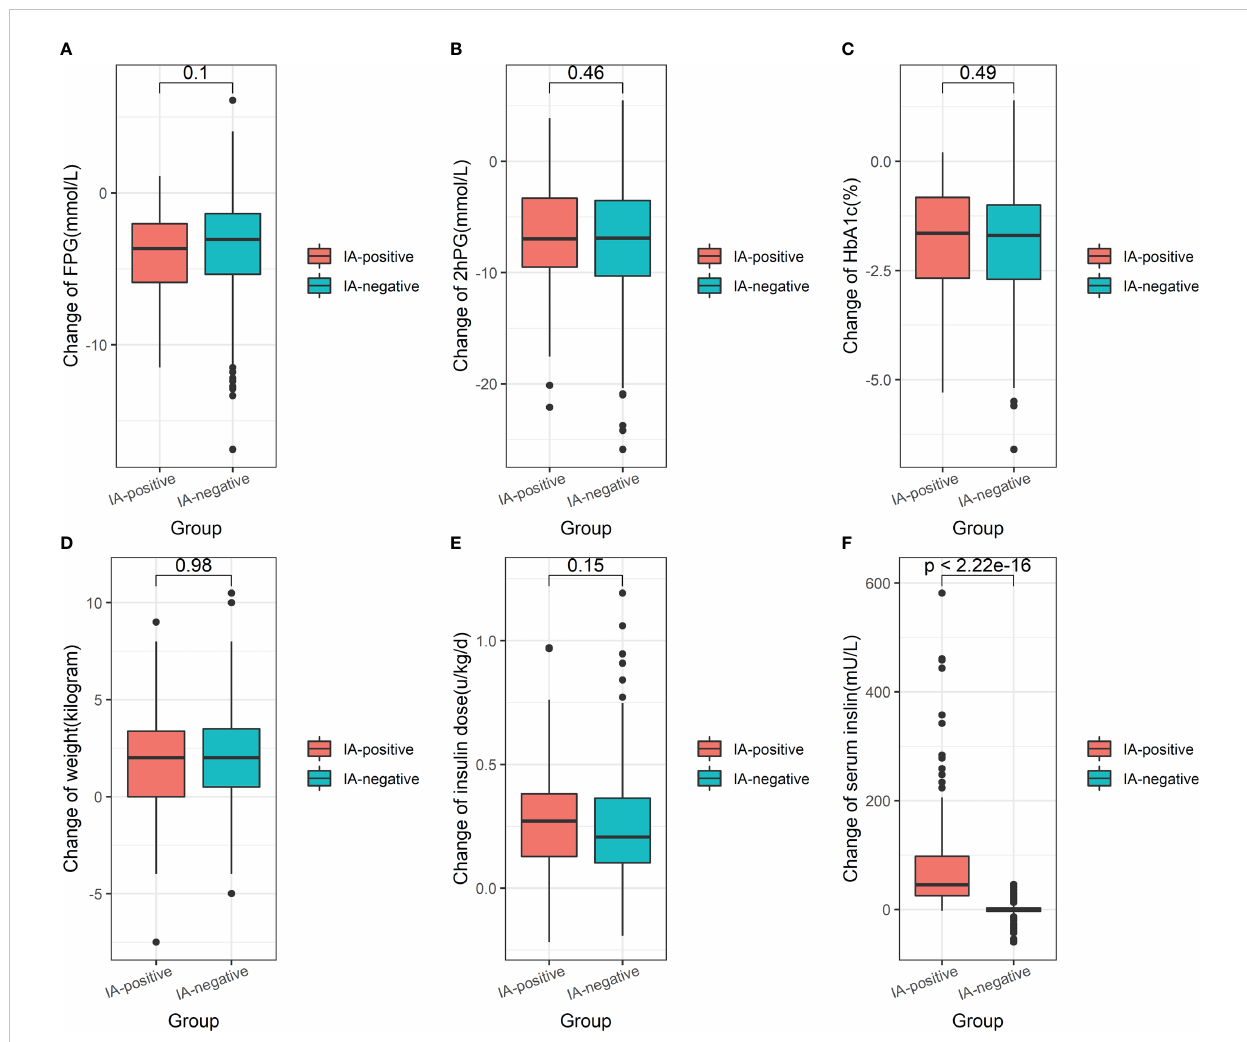
FIGURE 3 The boxplot showing the median change of FPG (A) , 2hPG (B) , HbA1c (C) , weight (D) , serum total insulin (E) , and daily insulin dose (F) from baseline in IA-positive patients and IA-negative patients. FPG, fasting plasma glucose; 2hPG, 2-hour postprandial blood glucose; HbA1c, glycated hemoglobin. Data on serum fasting insulin measured before and post-insulin administration were available in 94 IA-positive and 407 IA-negative